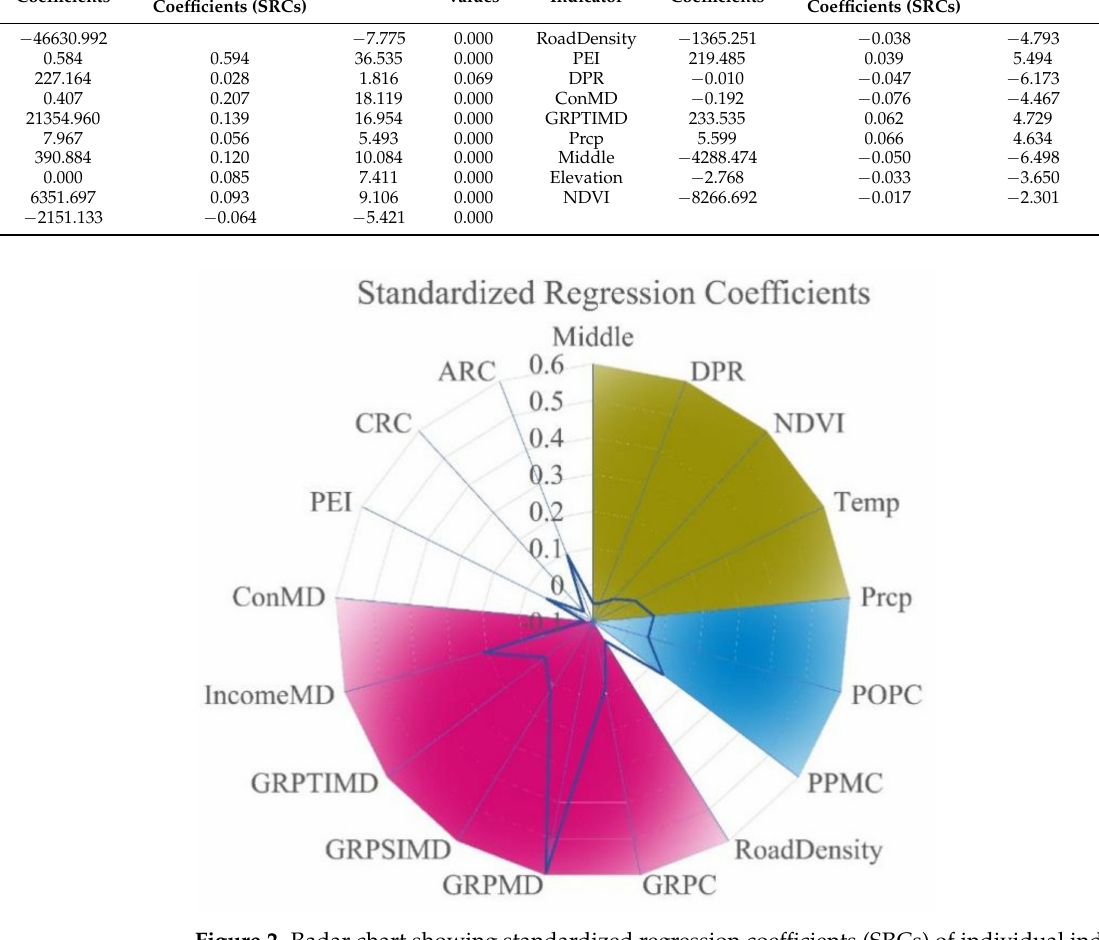
coefficient (SRC) was 0.066), while the indicator Middle had the most negative impact (SRC was − 0.050). In addition, terrain (represented by elevation (Elev) and Slope), distance to the primary river (DPR)), and vegetation (represented by Normalized Difference Vegetation Index (NDVI)) impacted STGRPP as